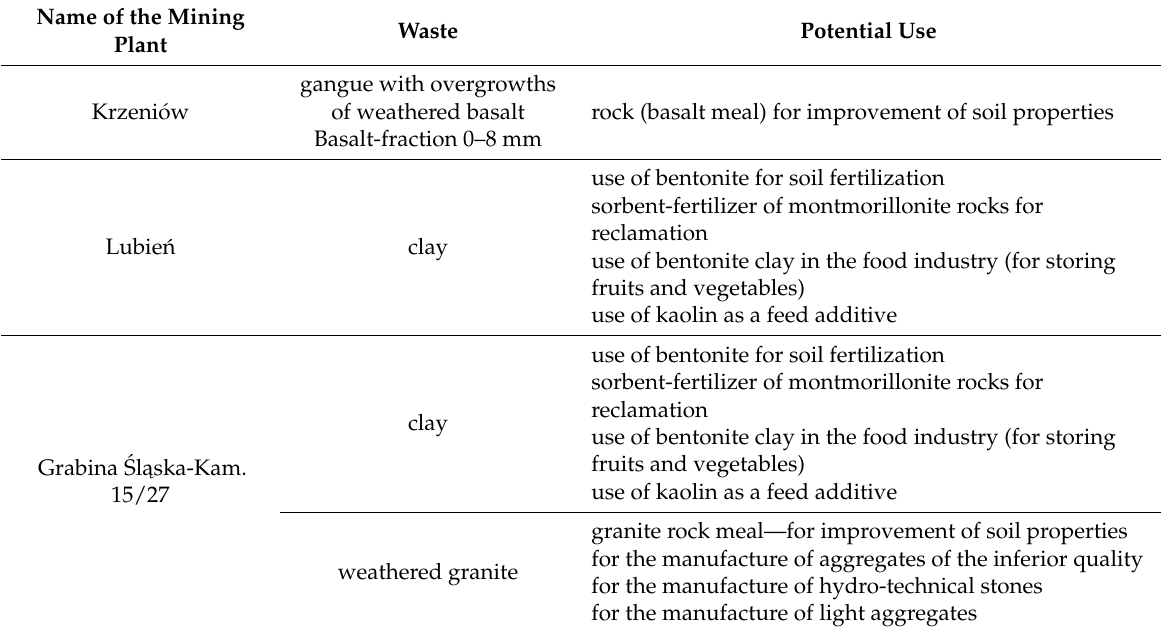
Table 5. Potential possibilities for using waste located in the selected facilities. Name of the